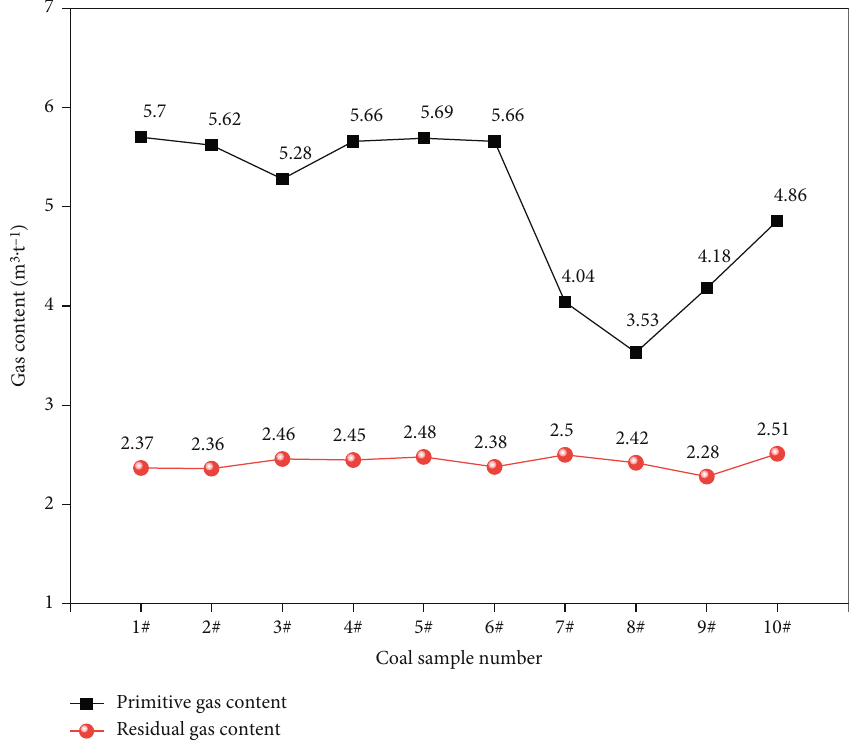
Figure 27: Determination results of gas content after coal seam extraction in fault